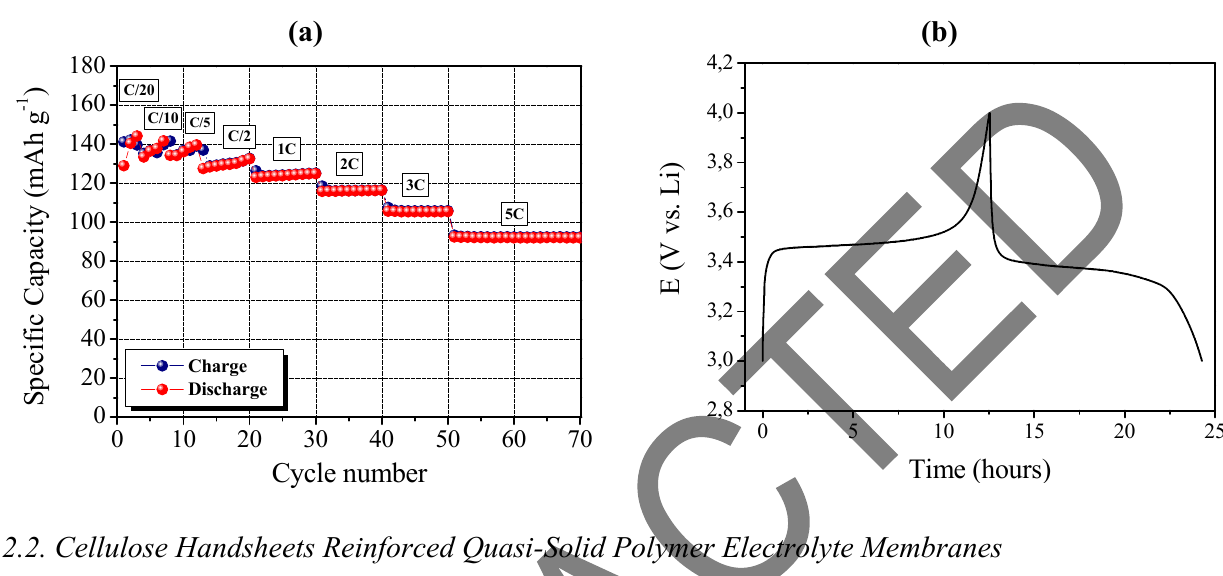
Figure 5. ( a ) Ambient temperature cycling performance of a LiFePO cell at different C-rates from C/20 to 5C (1C = 0.7 mA with respect to a LiFePO mass of about 4 mg); ( b ) Typical charge and discharge cycle run at ambient temperature.